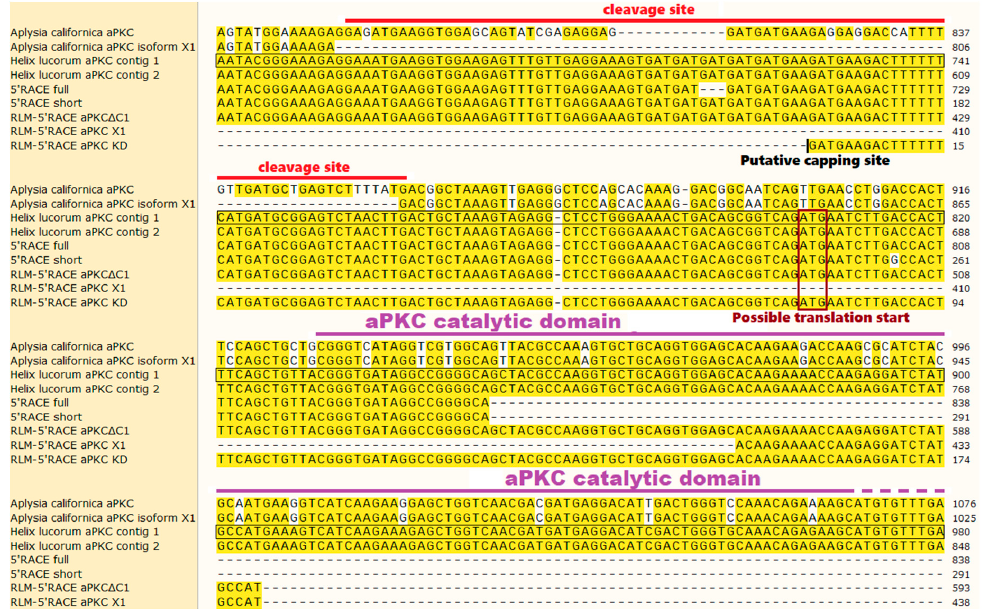
Figure A1. Multiple alignment of two Aplysia’s aPKC mRNA isoforms ( Aplysia californica aPKC and Aplysia californica aPKC isoform X1), two snail mRNA contigs (assembled from snail full-transcriptome sequencing data) homological to Aplysia’s aPKC mRNA ( Helix lucorum aPKC contigs 1 and 2), two classic 5’RACE sequences (5’RACE full and 5’RACE short), and three RLM-5’RACE sequences (RLM-5’RACE aPKC Δ C1, RLM-5’RACE aPKC X1, and RLM-5’RACE aPKC KD). The 3’-part of the sequence coding the catalytic domain is not shown because no 5’-RACE fragment aligned to it. Yellow coloring represents similarity to the common reference sequence Helix lucorum aPKC contig 1 (framed). Domains and features are located based on the information about Aplysia’s aPKC mRNA [36]. Red frames mark two possible translation starts present only in snail sequences.